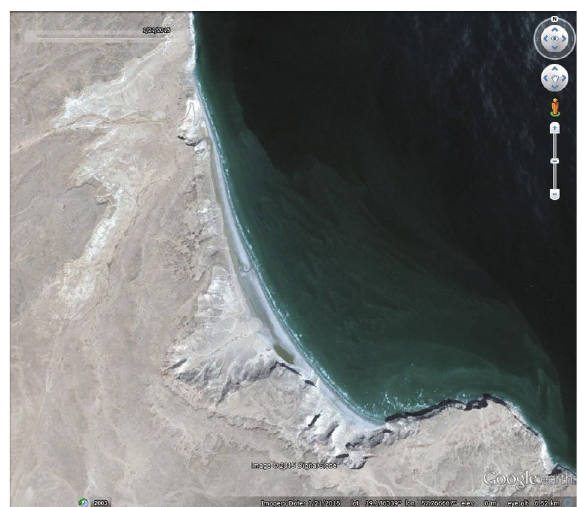
Figure 3: Plan shape of Ras Markaz crenulated bay.